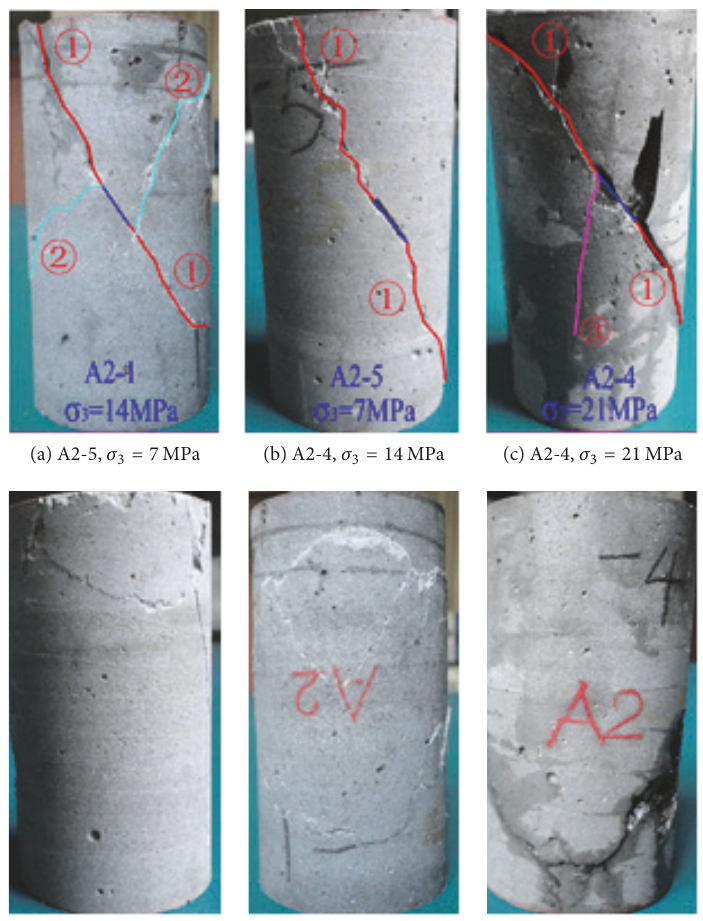
Figure 9: Fracture modes of specimens with different confining